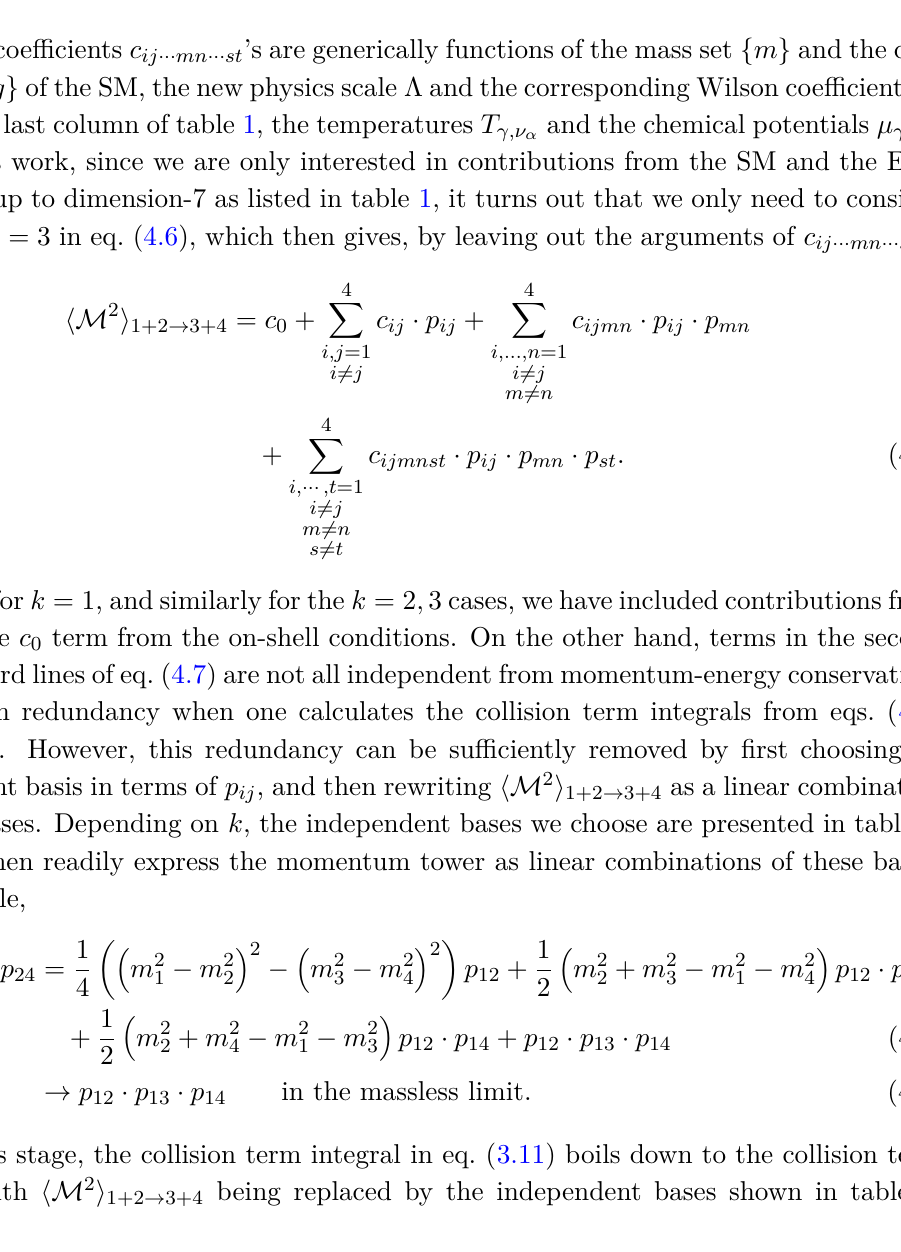
Table 2 . The bases we choose with different k ’s for the calculation of collision term integrals. See the main text for more